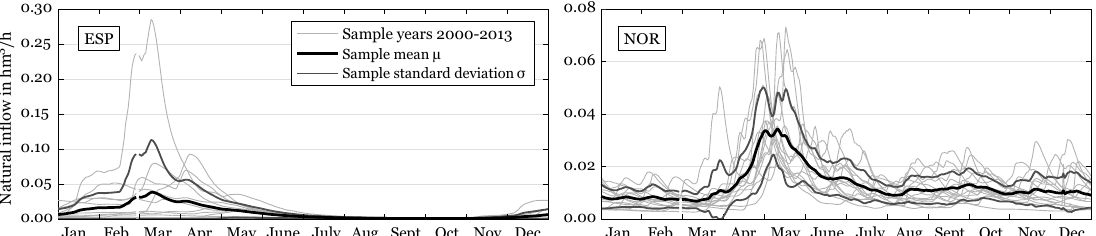
Figure 3. Simulated hourly natural inflow profiles of two exemplary hydro reservoirs in Spain and Norway for the meteorological years 2000–2013 (February break indicates missing day of data for non-leap